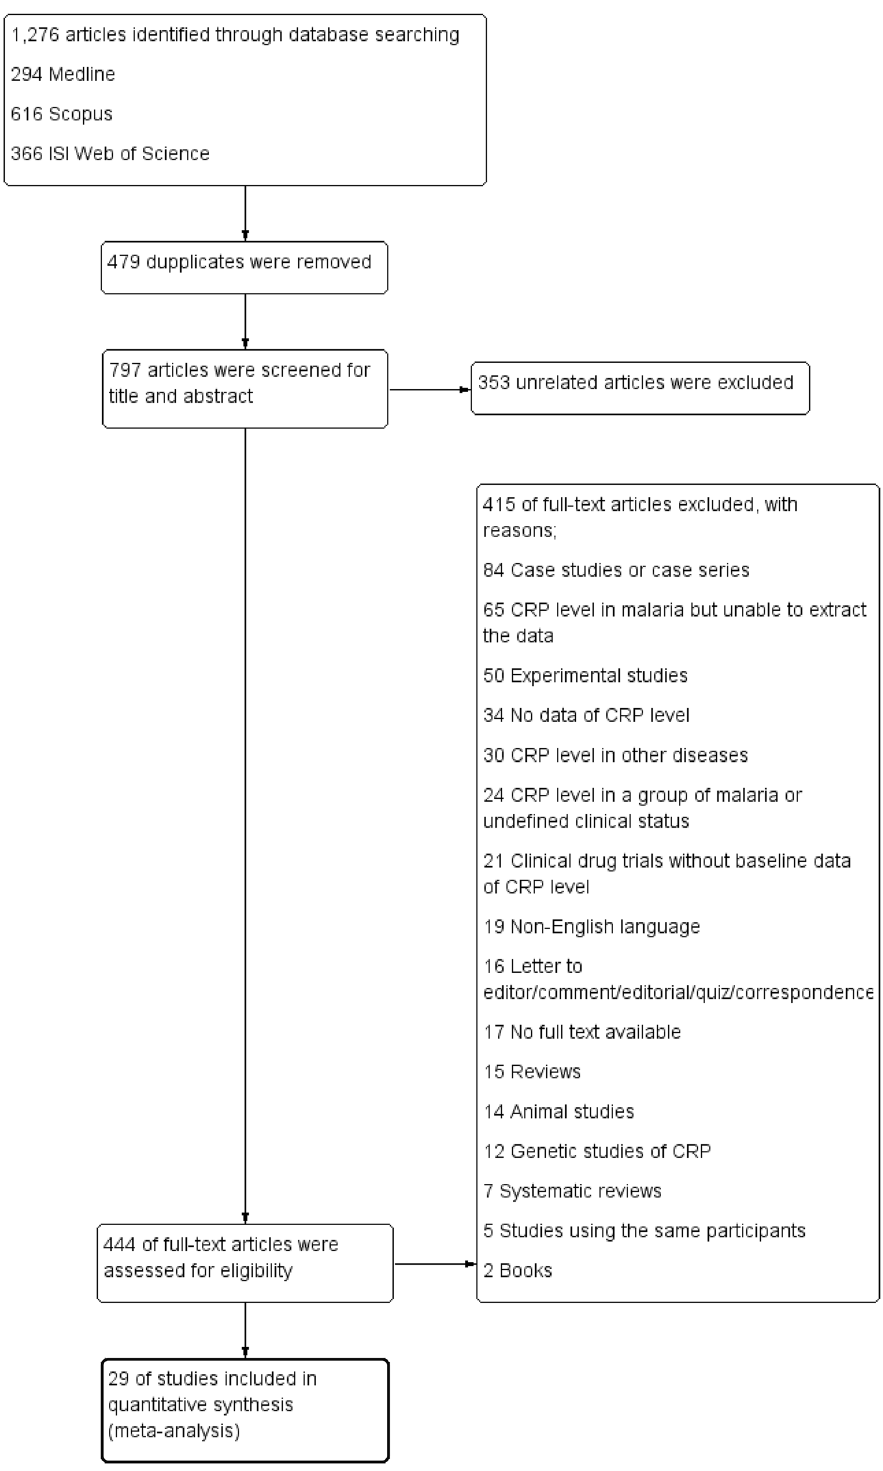
Figure 1. Flowchart for the study selection. Flowchart demonstrates the selection of potentially relevant studies for this